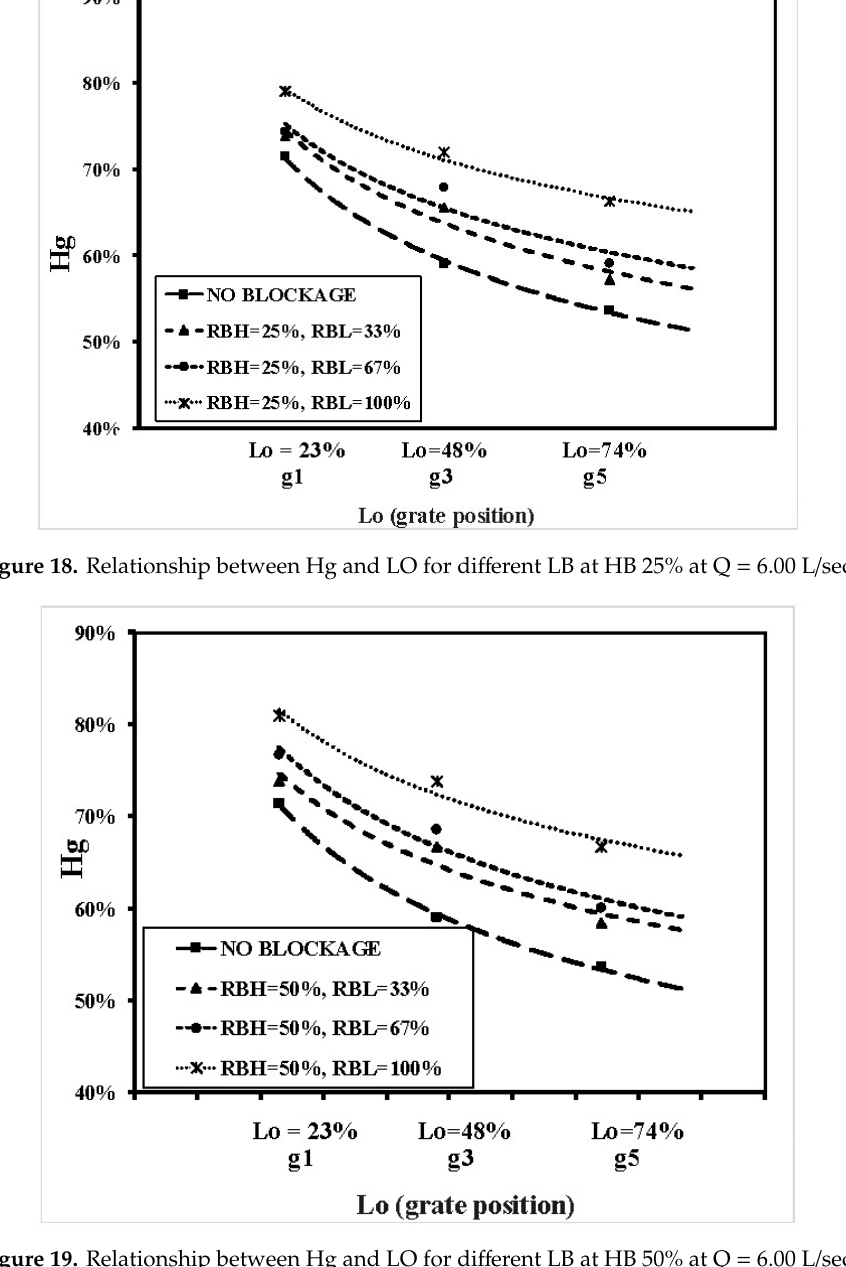
19 Figure 19. Relationship between Hg and LO for di